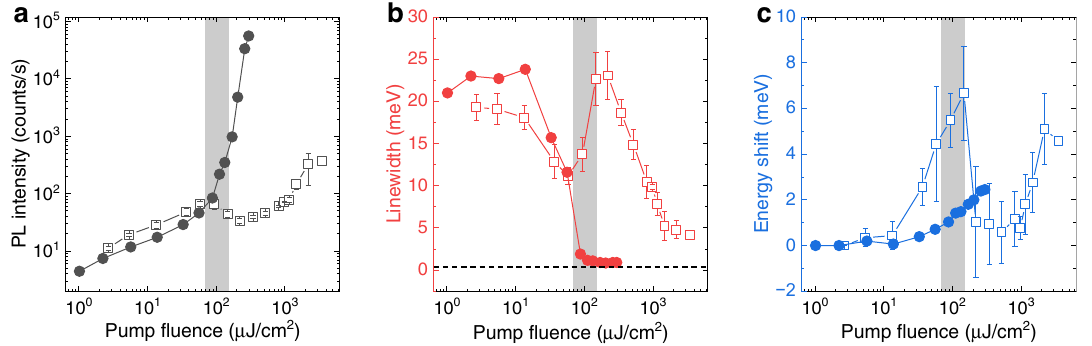
Fig. 5 | Power dependence of single and square-shaped pump spots. a – c PL intensity,linewidth,andpeakenergyshiftofspatiallyresolvedspectraversuspump fl uence pumped by single (open squares) and four (solid circles) laser spots. Error barscorrespondtothestandarddeviationover fi vedifferentsamplelocations.The